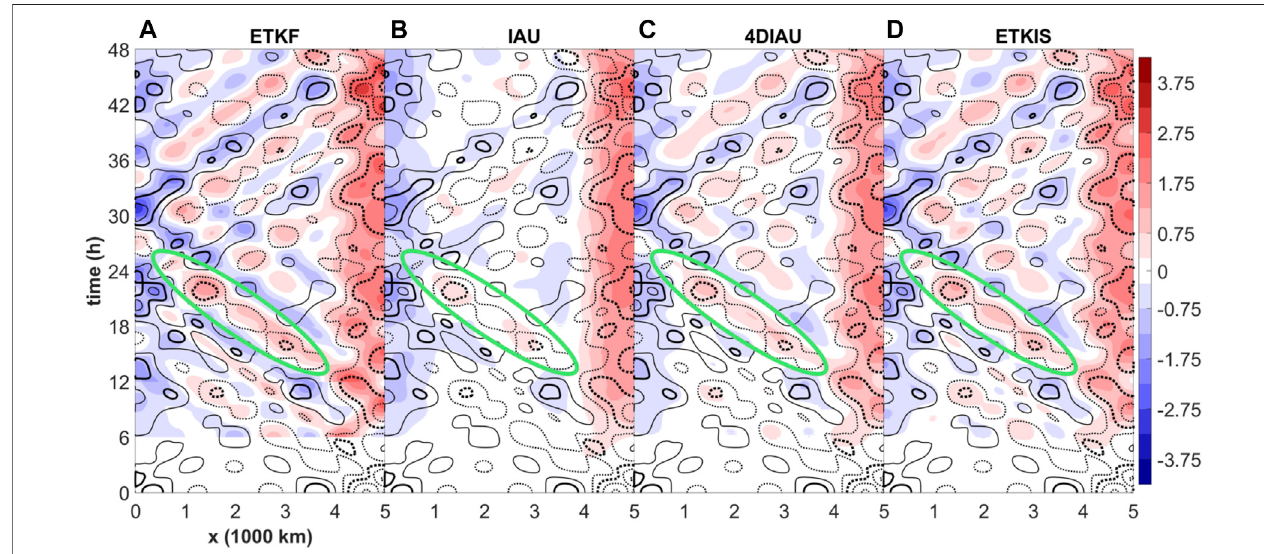
FIGURE3| Temporalevolutionoftheherror(contour)andcumulativecorrection(shaded)intheshallow waterexperiments usingdifferentDAschemes: (A) ETKF, (B) IAU (C) 4DIAU,and (D) ETKIS.Experimentsareinitializedfromabalancedcondition.ThecumulativecorrectioniscalculatedasthedifferencebetweenNoDAandDA experiments. Contour value ranges from − 3.75 to − 0.75 (dashed) and 0.75 to 3.75 m with 1-m interval; values of 1.75 and − 1.75 are denoted with thick contours.